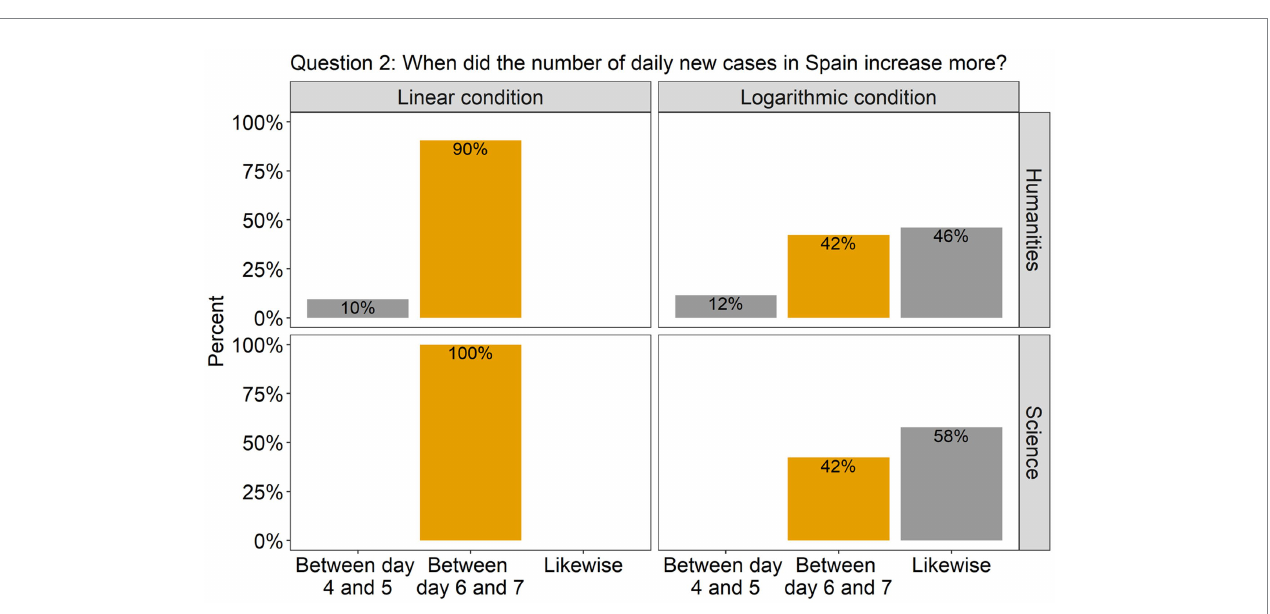
FIGURE 3 The barplots present the distribution of the participants’ answers to Question 2 (graph description question). The correct answer is indicated with orange- colored